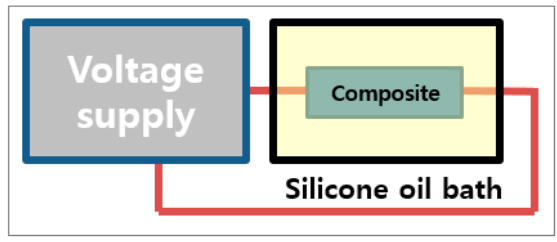
Figure 4. Schematics of PVDF/PAR composite poling process.